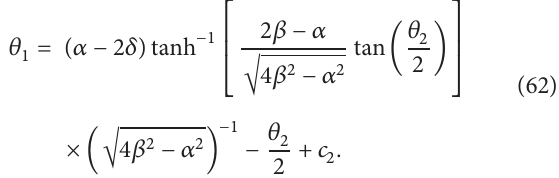
Figure 5: Control and state variables of the optimal solution of problem 2, an initial value problem for a 𝑅𝑅 robot manipulator with boundary conditions 𝜃 1 (𝑡 𝐼 ) = 0 [ rad ] , 𝜃 2 (𝑡 𝐼 ) = −𝜋/2[ rad ] , ̇𝜃 (𝑡 ) = 0 [ rad / s ] . The initial and final times are 𝑡 and 2 𝐹 robot manipulator at times 𝑘(1/32) with 𝑘 = 0, 1,. .. ,32 is represented in Figure